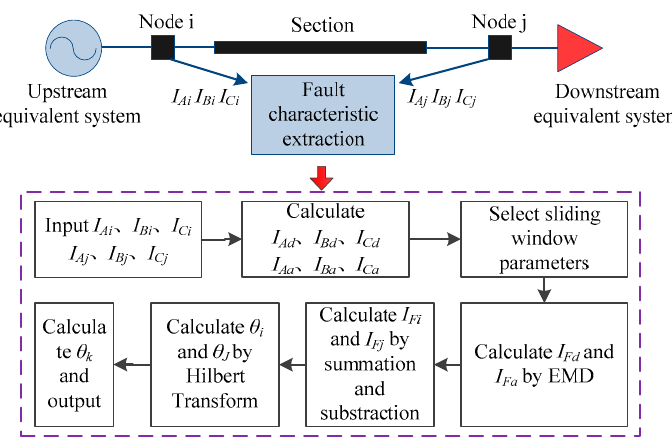
Figure 1. Extraction process of the proposed fault characteristic.